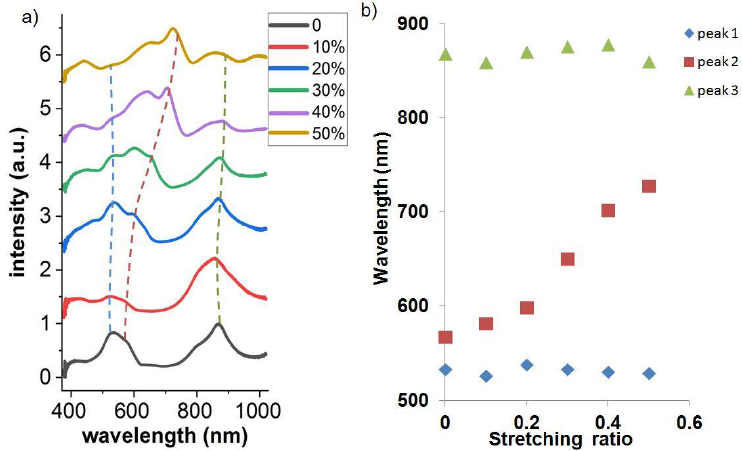
Figure 6. ( a ) Normalized scattering spectra of the 2D gold grating at different stretching lengths; ( b ) the resonance peak varies with the position of the stretching ratio.